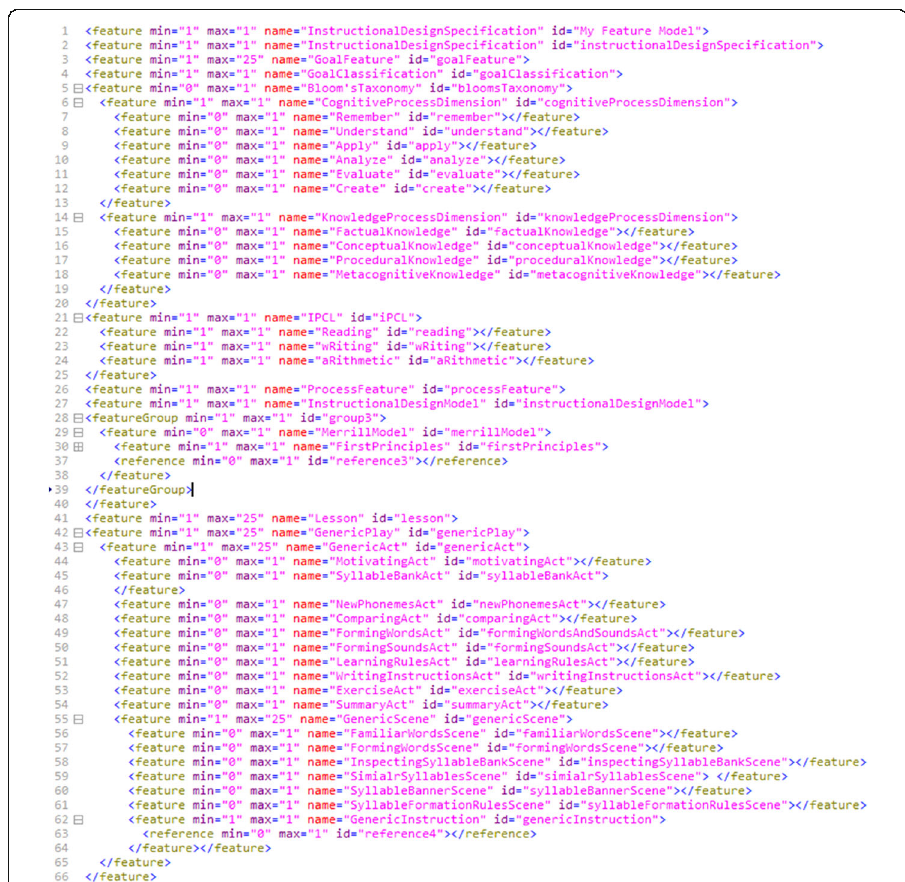
Fig. 9 Instantiation of ID ont framework for adult